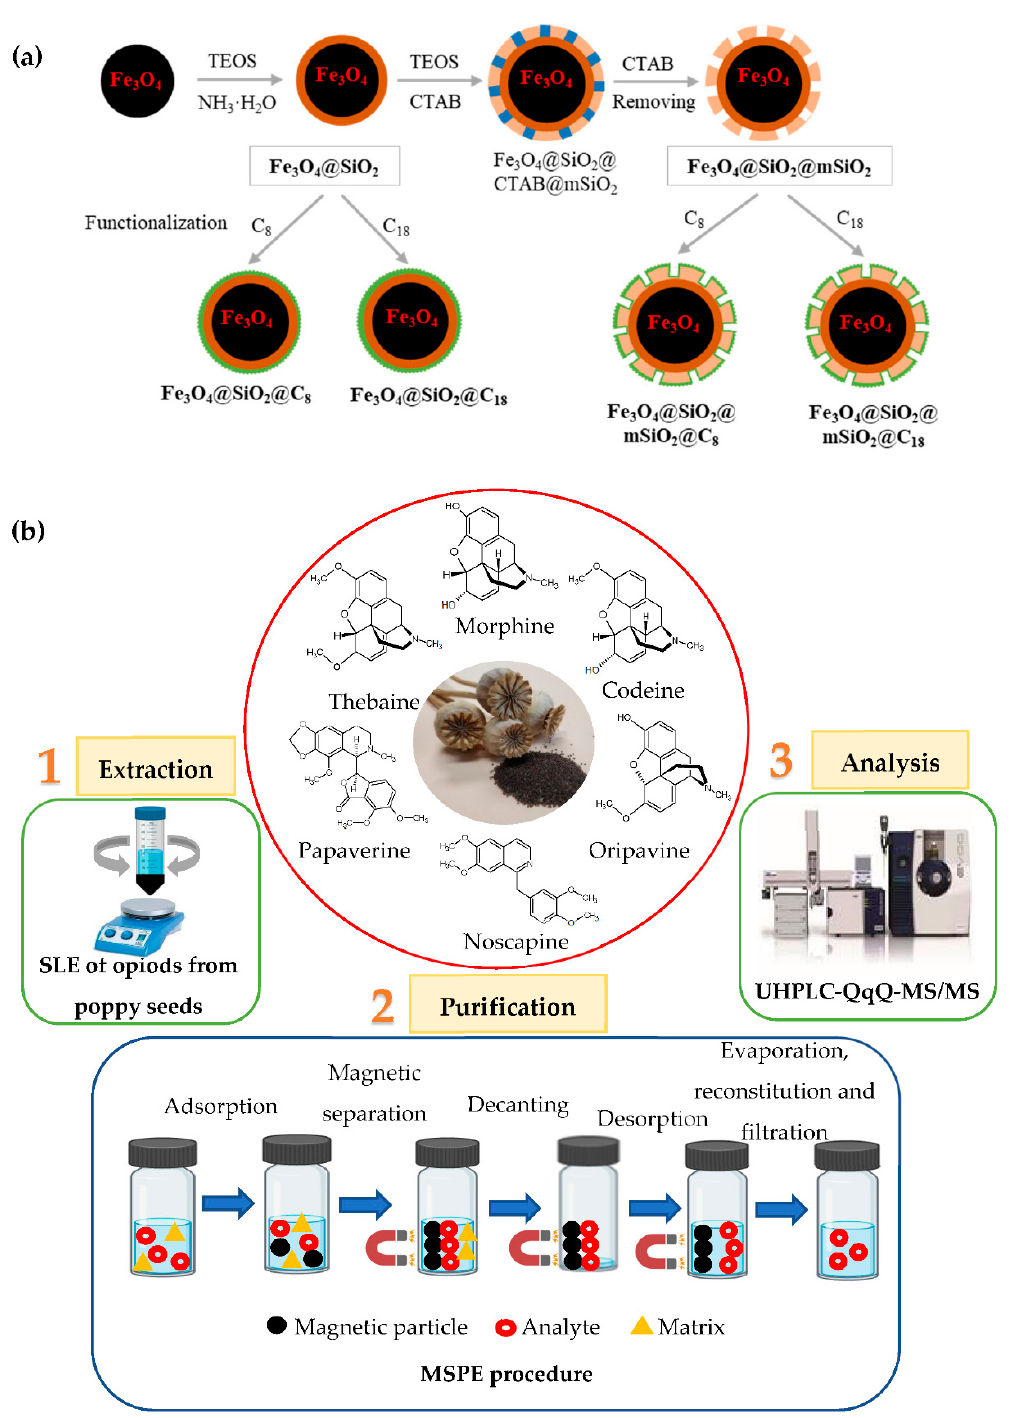
Figure 1. Schematic preparation process of the six types of magnetic particles synthesised ( a ). Diagram of proposed methodology to quantify opioids from poppy seeds: extraction (SLE), purification (MSPE) and analysis (UHPLC-QqQ-MS/MS) and chemical structures of the six most common opium alkaloids in contaminated poppy seeds ( b ).